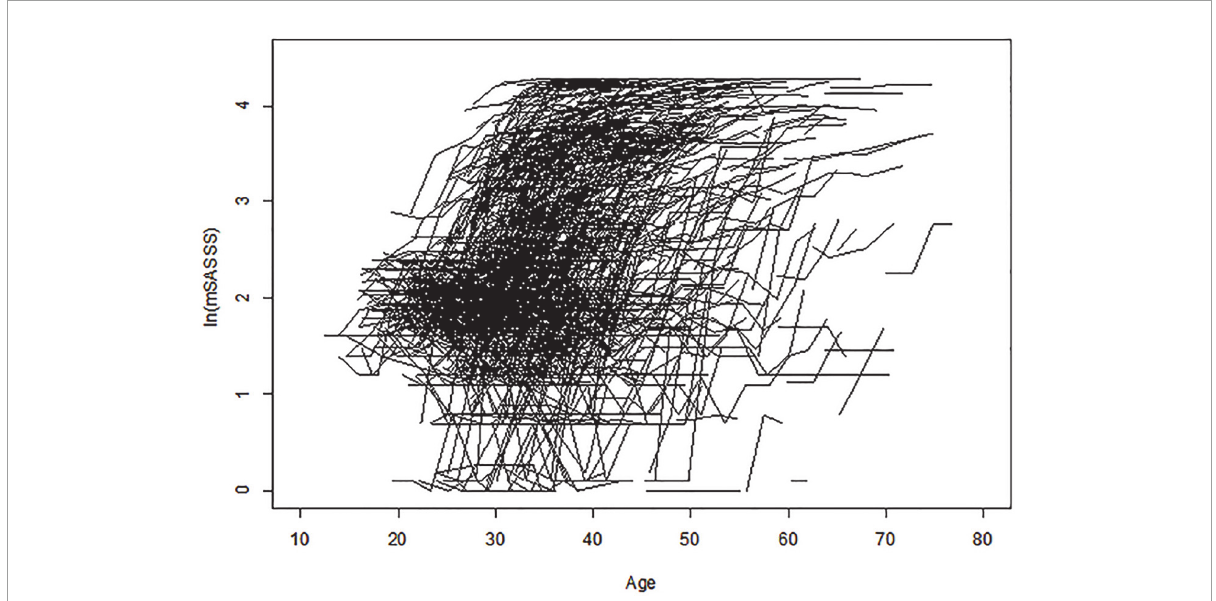
FIGURE2 Change in individual patient mSASSS. Age is shown along the x-axis, and logarithmic transformed total mSASSS is shown along the y-axis. Each individual line represents a patient entry with the total mSASSS of at least two sets of radiographs. mSASSS, modified Stoke Ankylosing Spondylitis Spinal Score.